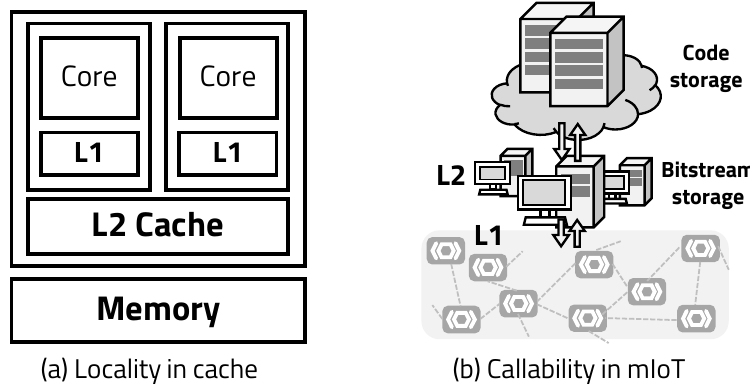
Figure 5. Similarity between callability and locality.